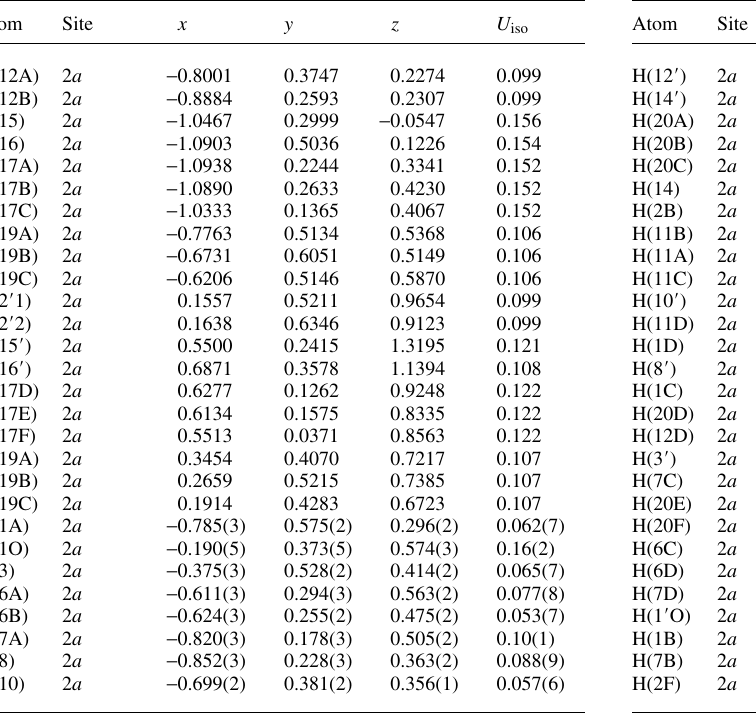
Table 2. Atomic coordinates and displacement parameters (in Å 2 ) .